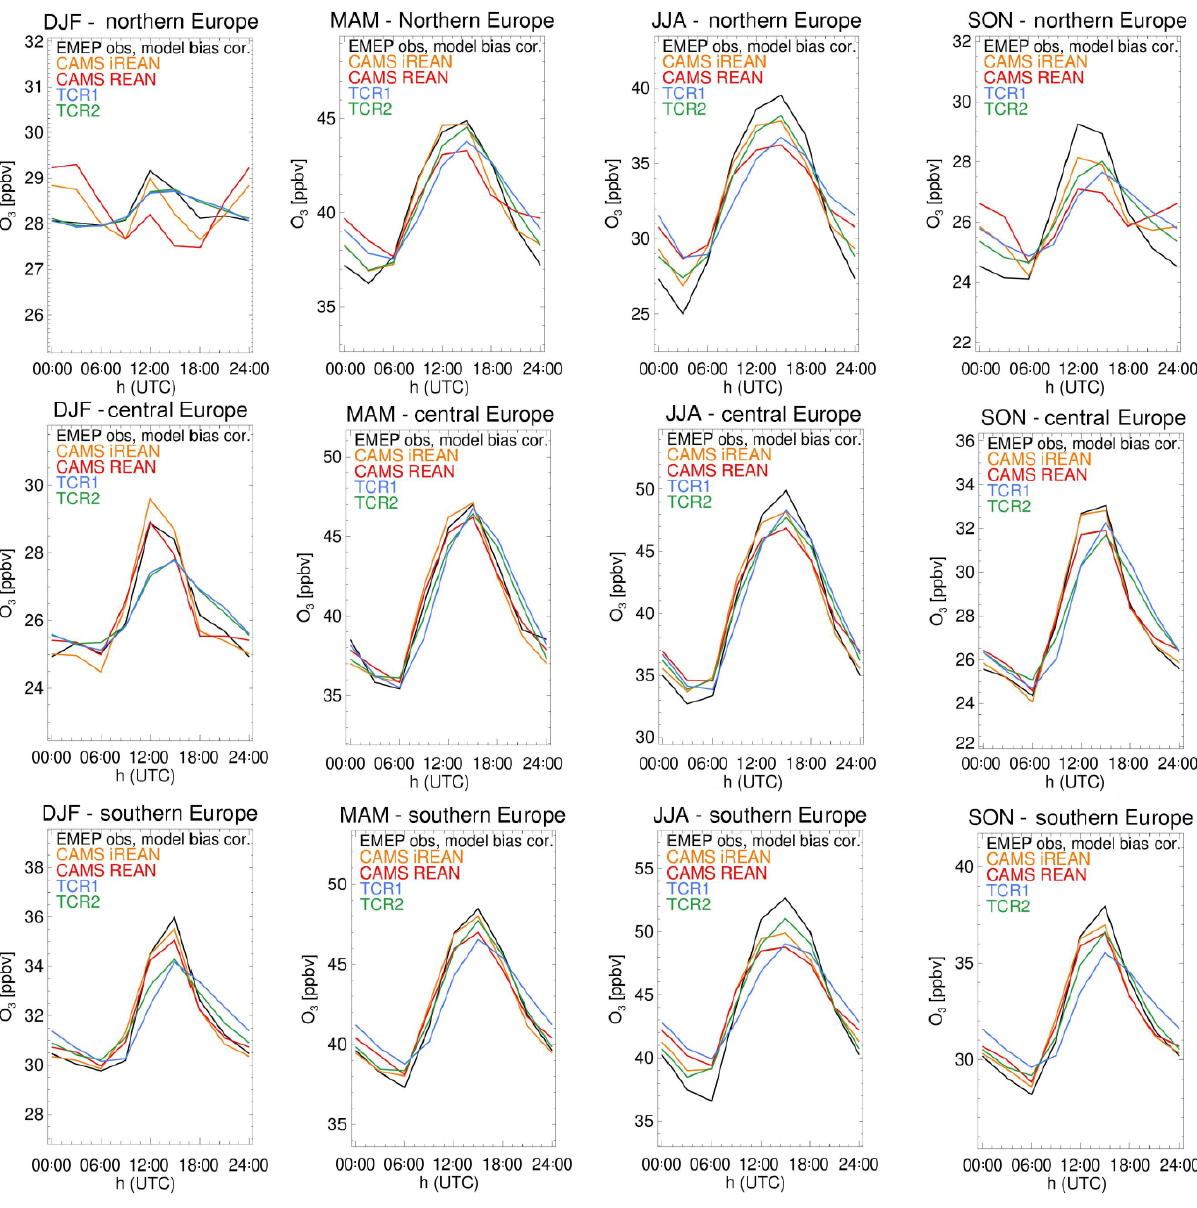
Figure 13. Plots of seasonal mean diurnal cycle against EMEP observations for 2006. Central Europe is here defined as the region between 35 and 45 ◦ N, with northern (southern) Europe at higher (lower) latitudes. Note that the reanalysis bias has been removed. Model level selection is through matching of the reanalysis pressure with pressure level of the station